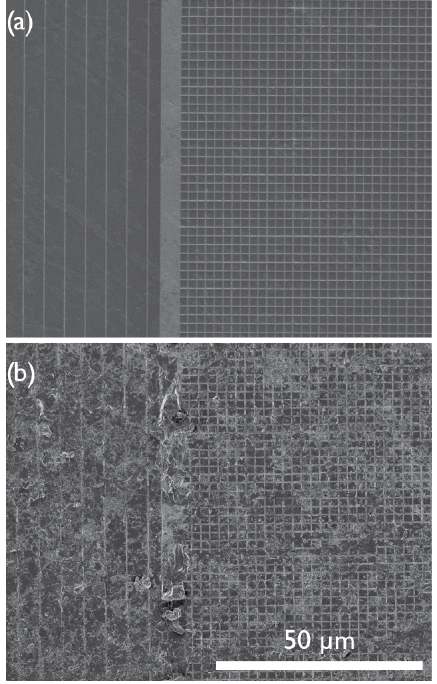
Figure 15. Secondary electron micrographs of a patterned Solnhofen limestone sample (a) before deformation and (b) after deformation at T = 700 ◦ C and P c = 300MPa to 9% shortening strain at 3 × 10 − 4 s − 1 . Before deformation, the pattern consisted of 200nm wide lines spaced every 5µm and a grid of 200nm lines spaced every 2µm. The lines were made of 110nm thick chromium. After deformation, the lines are clearly deformed but the grain struc- ture is not